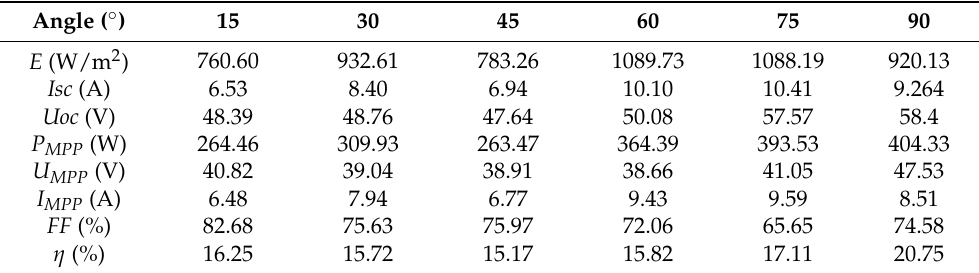
Table 8. Results of measurements and calculations for a foil substrate.